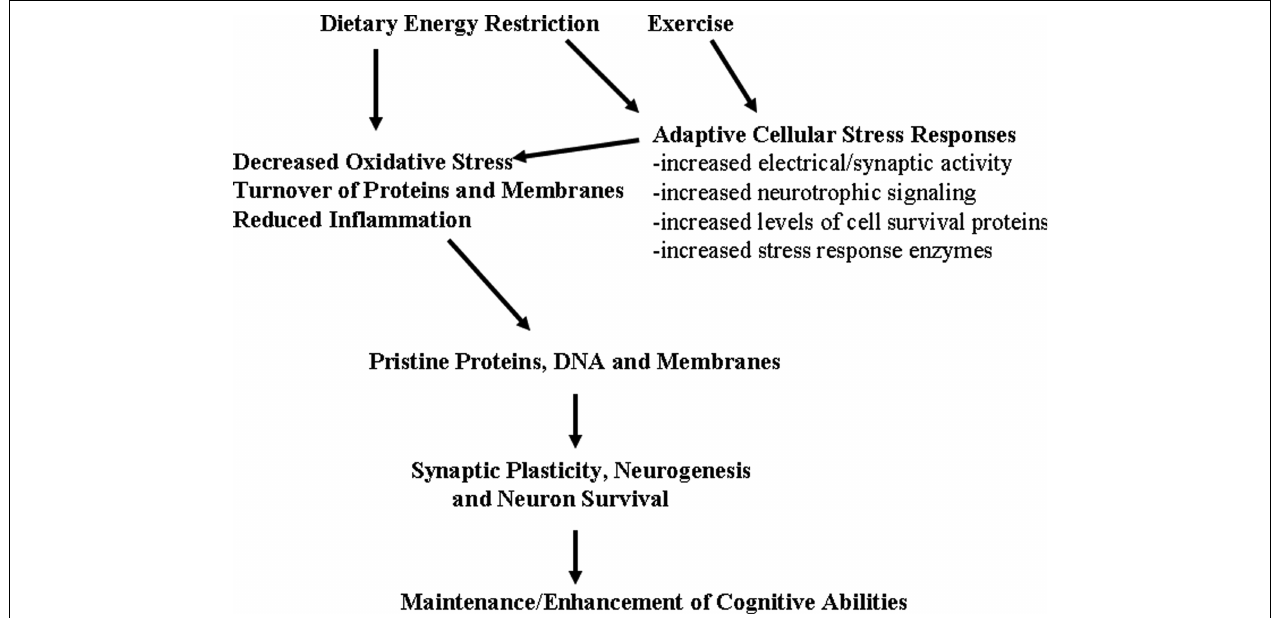
FIGURE 2 | Hormetic mechanism of action of dietary energy restriction. A mild cellular stress occurs in neurons during periods of dietary energy restriction or vigorous physical exercise; this may result from increased electrical/ synaptic activity and/or an energetic defi cit. Adaptive cellular stress response signaling pathways are activated in brain cells including those that induce the